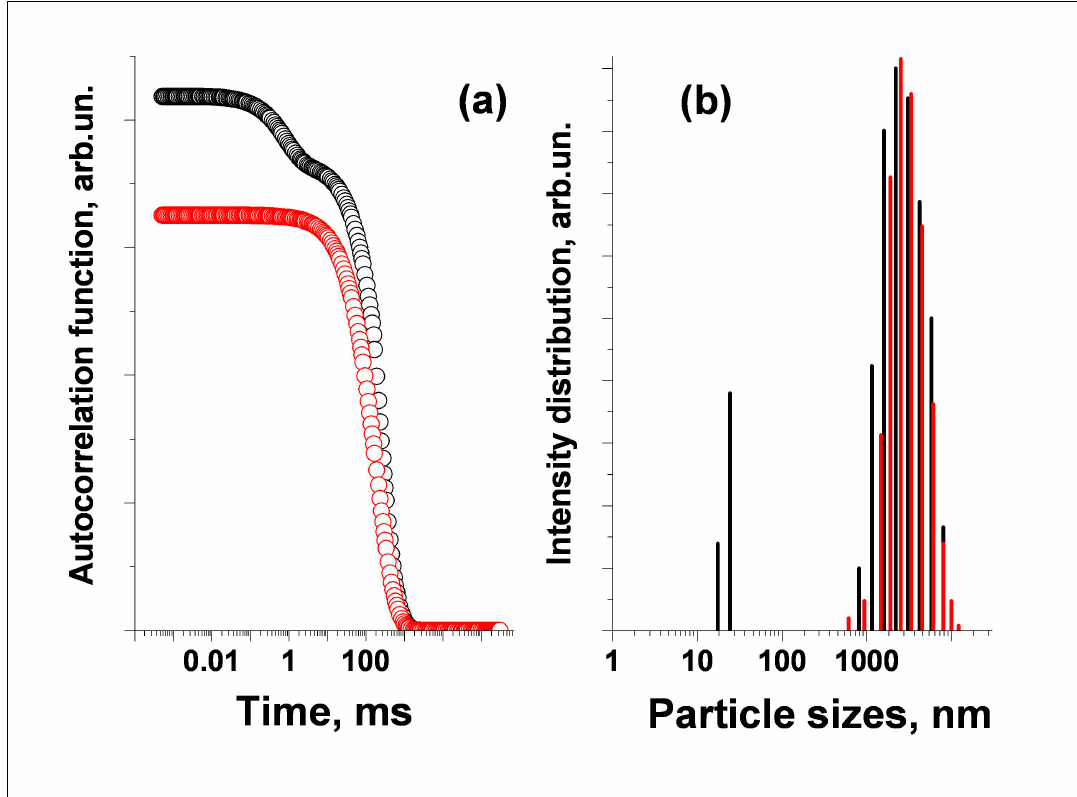
Figure 3. ( a )Typical autocorrelation functions for sols prepared from Ag/ γ -Al 2 O 3 (black line) and γ -Al 2 O 3 (red line), respectively. ( b ) Intensity distributions for sols prepared from Ag/ γ -Al 2 O 3 (black line) and γ -Al 2 O 3 (red line), respectively.